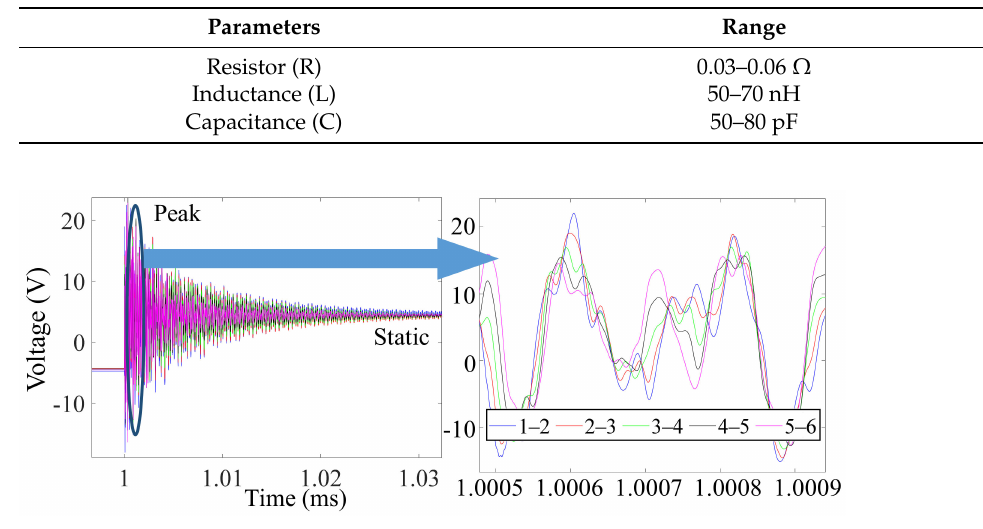
Figure 6. Overall ( left ) and partial zoom in ( right ) of the rising edge interturn voltage drop waveform on the rising edge of pulse